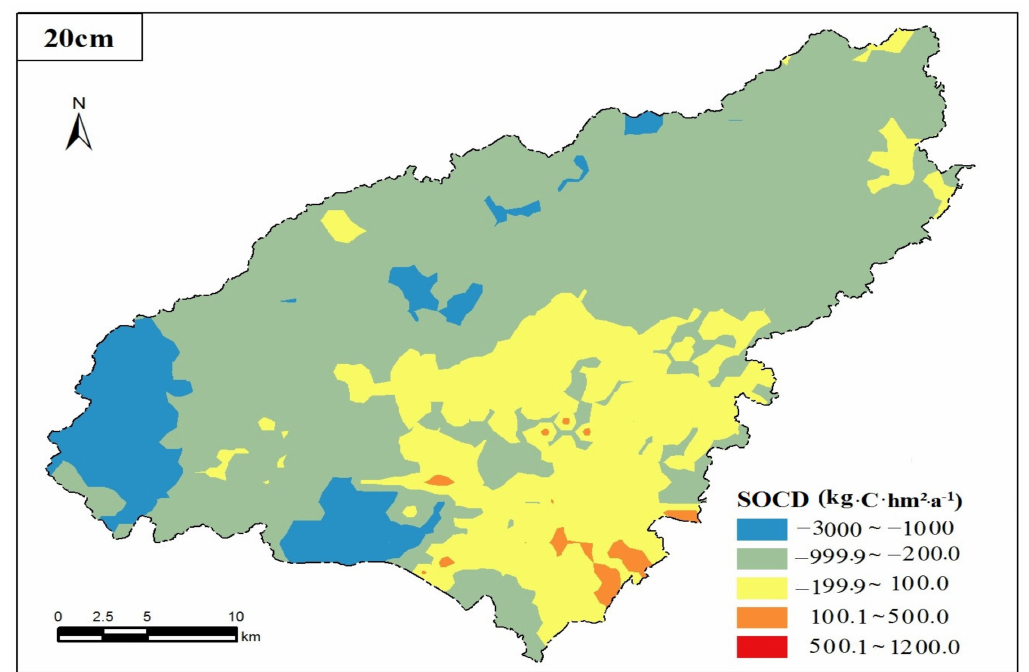
Figure 3. Spatial distribution pattern of annual variation of SOCD in surface soil of farmland in Puding County from 1980 to